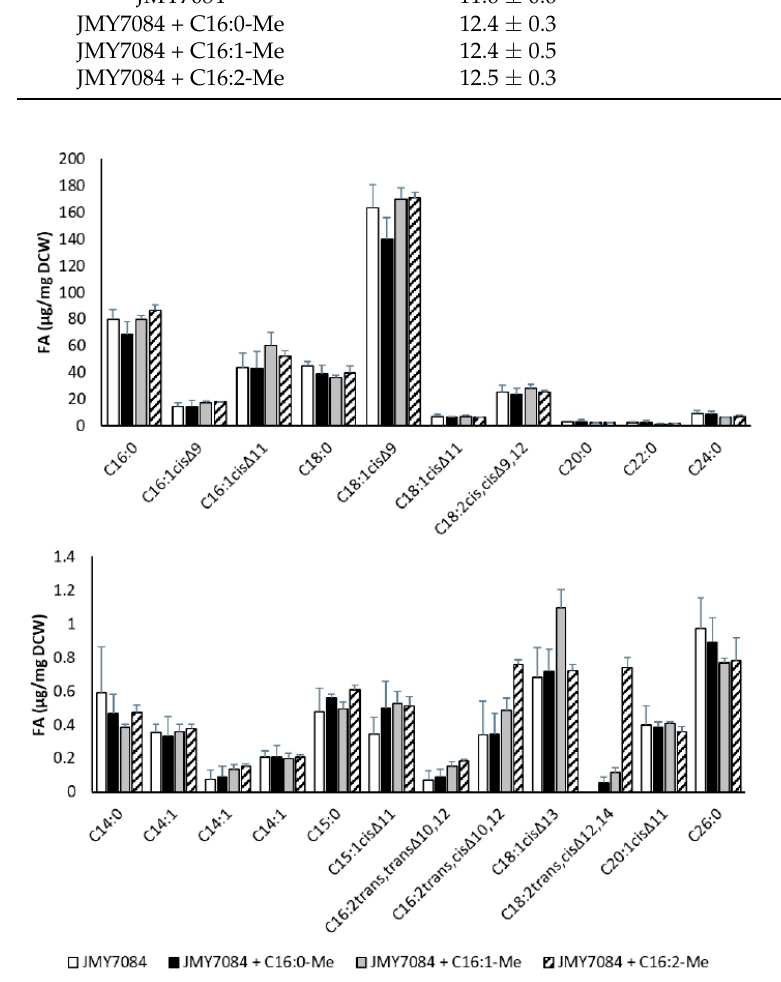
Figure 7. Fatty acid profiles of the strains JMY7084 (control without additives), JMY7084 +